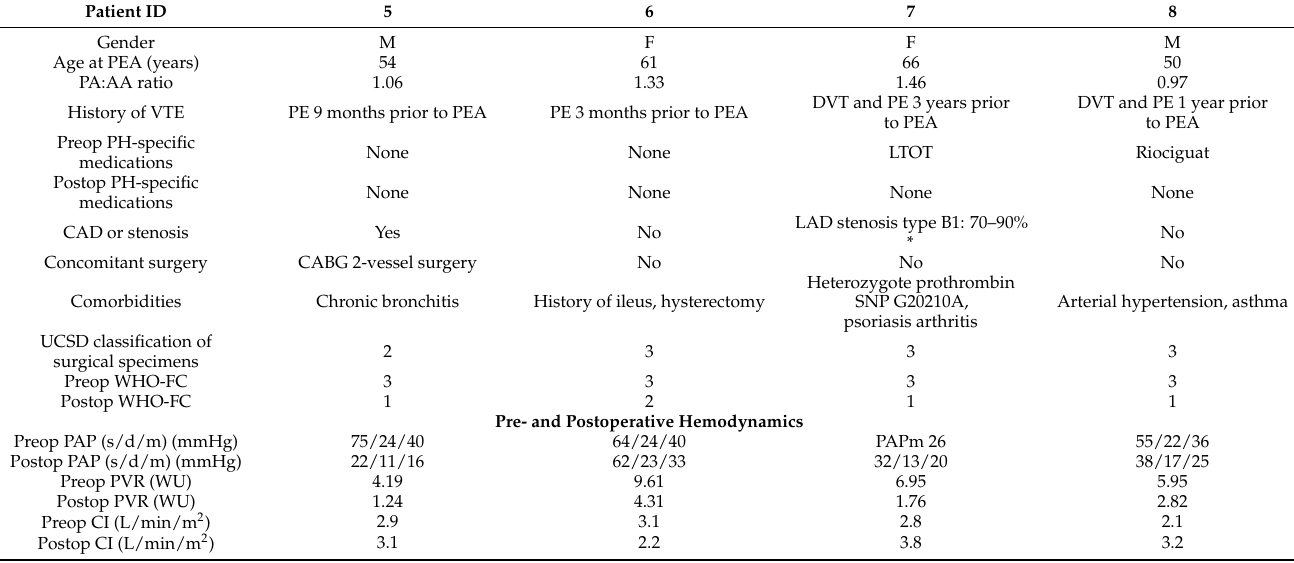
Table 2. Basic demographic and hemodynamic data of CTEPH